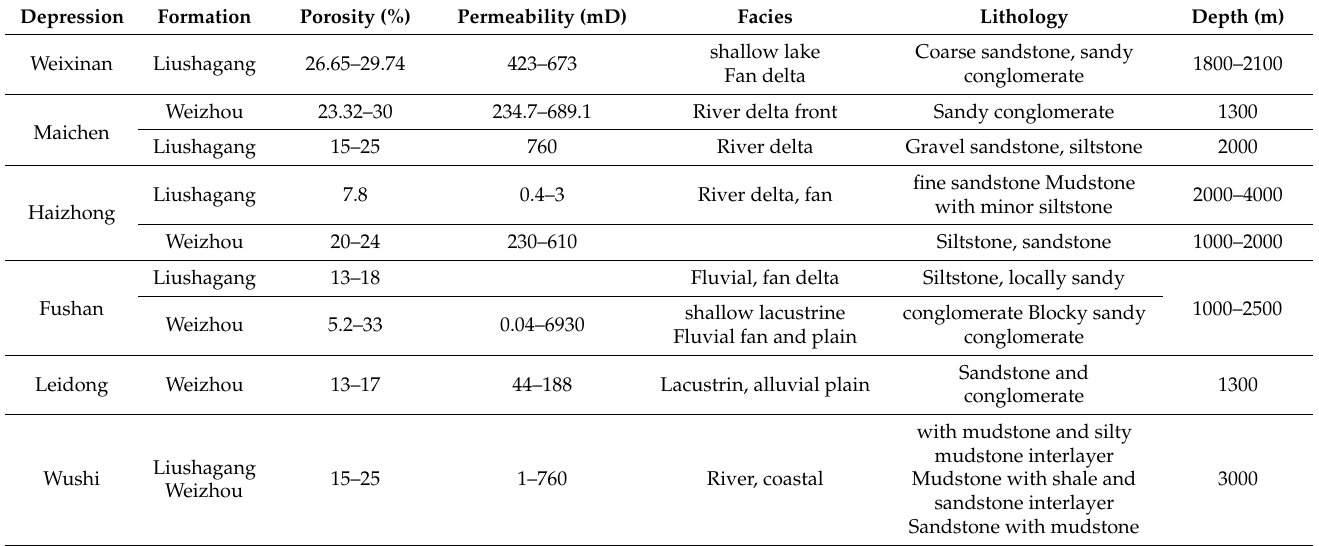
Table 5. Reservoir characteristics of the Beibu Gulf Basin (modified after